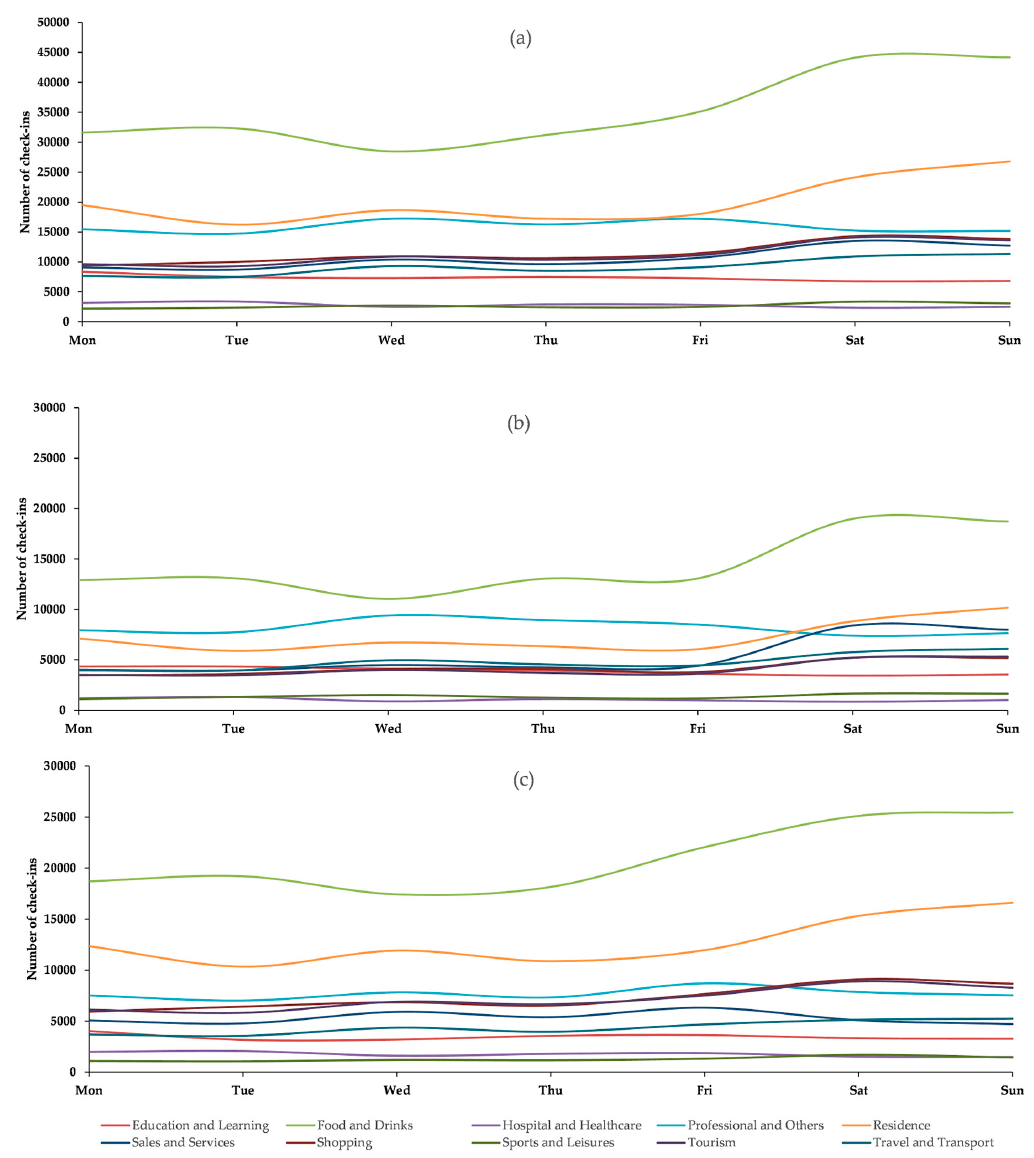
Figure 8. Check-in trend of activities during a week in Shanghai: ( a ) overall and for ( b ) men ( c ) and women.